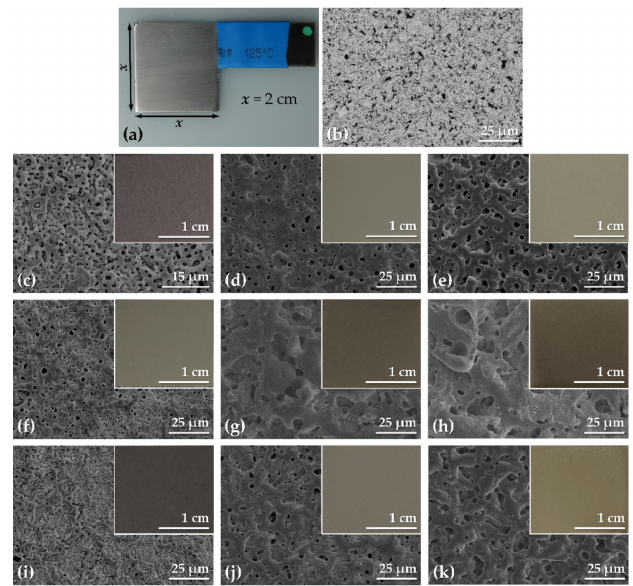
Figure 1. Macroscopic ( a ) and SEM ( b ) images of Ta specimen prior to PEO; SEM images of the Ta surfaces after PEO treatment carried out in the solutions: Ca1P2 ( c – e ), Ca5P3 ( f – h ) and (CaMg)5P3 ( i – k ); and up to the limiting voltages: 200 V ( c , f , i ), 300 V ( d , g , j ) and 400 V ( e , h , k ); insets found in the SEM images are the macroscopic appearances of the respective